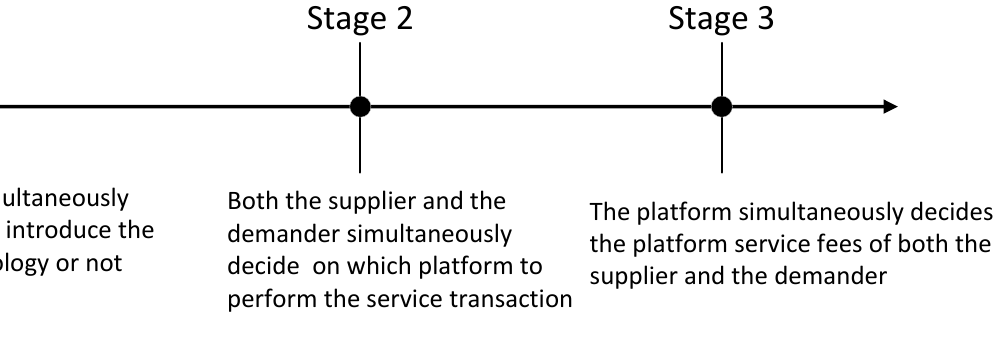
Figure 1. Timeline of the